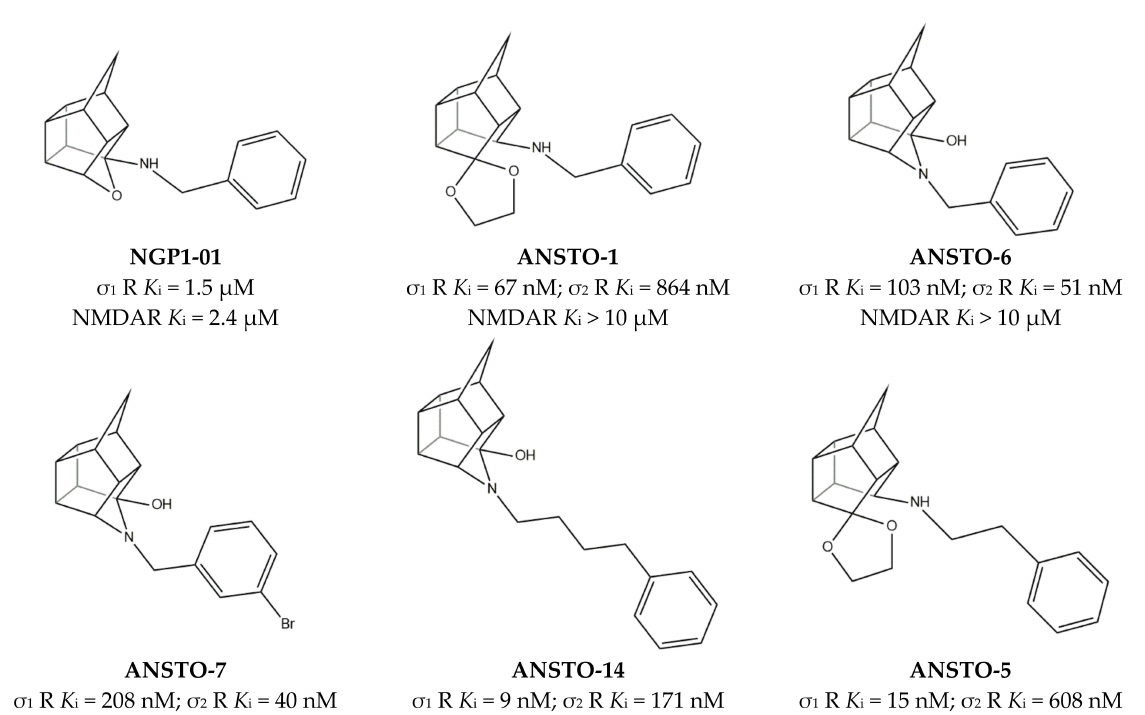
Figure 8. NGP-01 , ANSTO-1 , ANSTO-6 , ANSTO-14 , and ANSTO-5 structures and their K i values for σ receptor ( σ 1 R and σ 2 R) and N-methyl-D-aspartate receptor (NMDAR) [110–112].